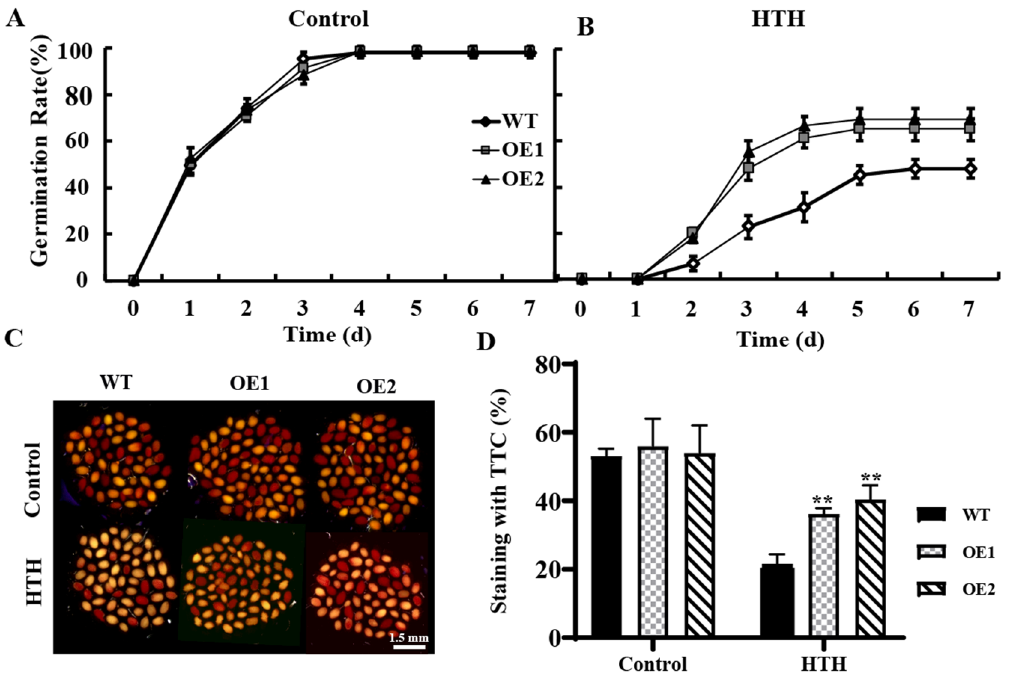
Figure 4. Germination rates and viability of the mature seeds harvested from the treated GmPAL1.1 overexpressing Arabidopsis (OE) lines and WT under normal condition and HTH stress at physiological maturity stage. Control plants (WT and OE lines) were placed in a normal growth chamber (26 °C/24 °C, RH 70%, light for 16 h/dark for 8 h) for 3 d. HTH-stressed plants (WT and OE lines) were put into artificial aging equipment (40 °C/24 °C, 98% RH/70% RH, light for 16 h/dark for 8 h) for 3 d. ( A ) Seed germination rates of WT and OE lines after the control treatment. ( B ) Seed germination rates of WT and OE lines after the HTH stress. ( C , D ) TTC staining of WT and OE lines after the control treatment and HTH stress, respectively. TTC staining was used to evaluate seed viability. Red seeds indicate viable seeds. Values are mean ± SD of three independent biological replicates. ** indicated significant differences at 1% probability levels between WT and transgenic Arabidopsis lines.